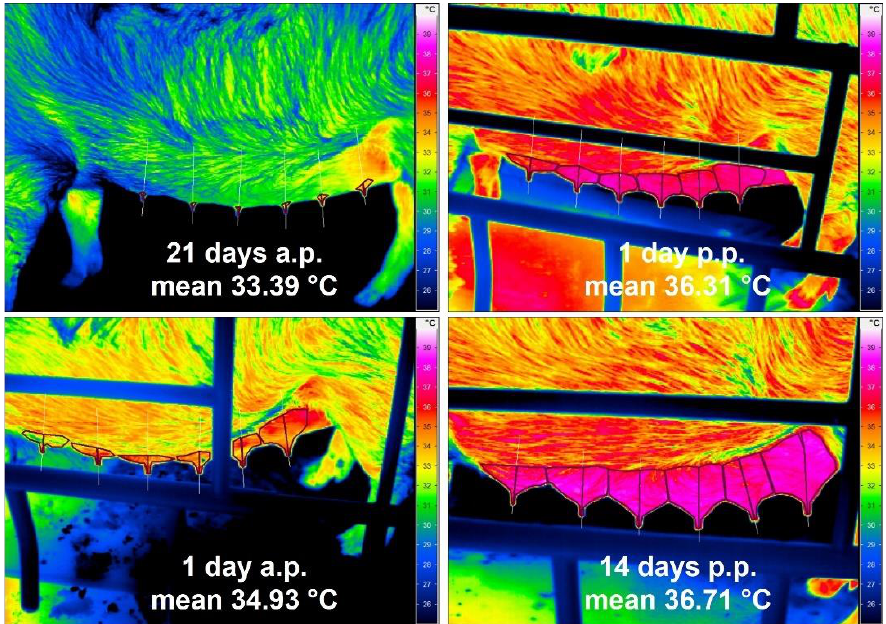
Figure 2. Four thermograms of the left teat row of a sow at four time points (21 d a.p., 1 d a.p., 1 d p.p., 14 d p.p.); mean values represent the mean surface temperature of all mammary glands of all sows (n = 35) on the respective day of pregnancy or lactation.